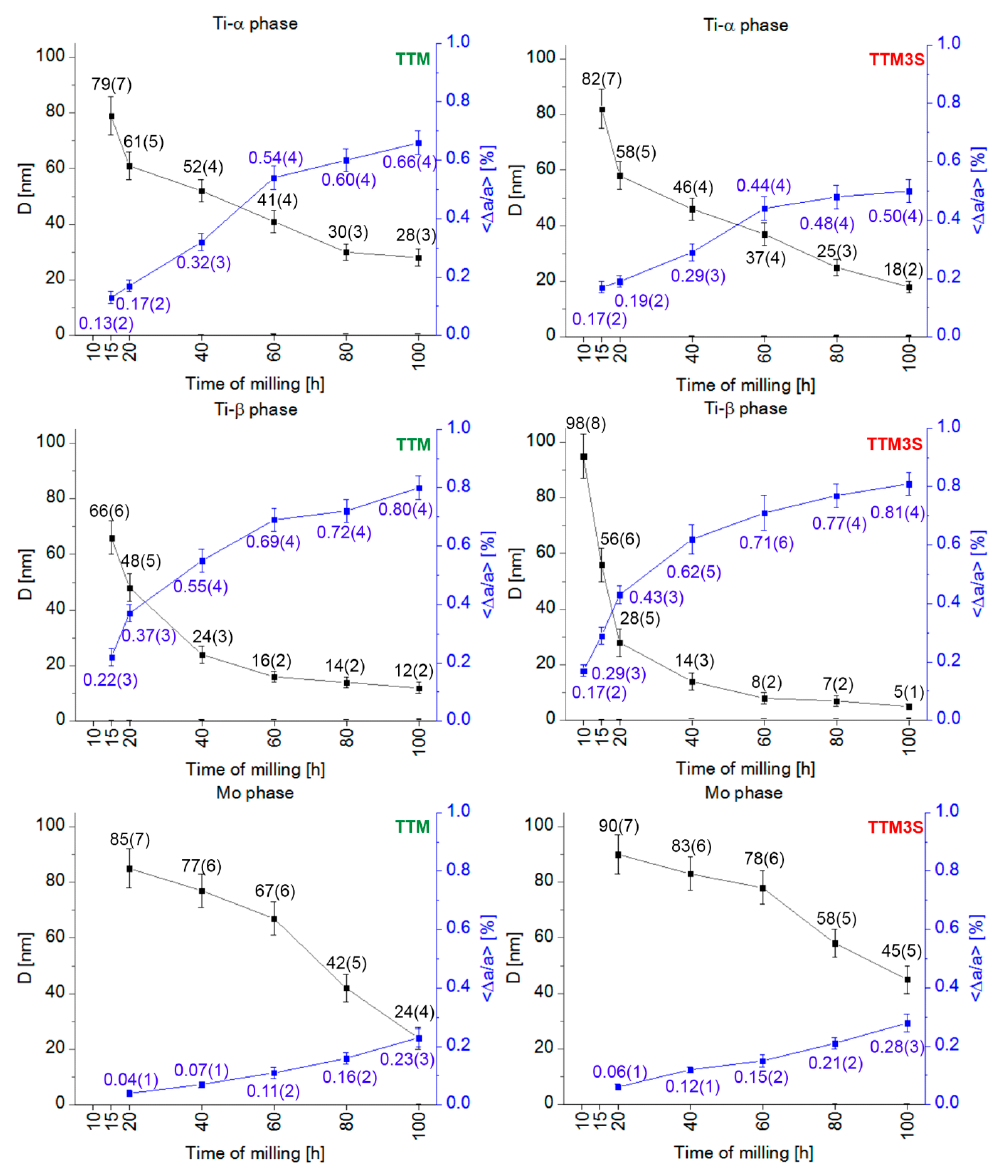
Figure 7. Changes in the average crystallite size (D) and lattice distortion ( < ∆ a / a > ) of the weight fractions of the α , β and Mo phases of the TTM and TTM3S powders after 10, 15, 20, 40, 60, 80 and 100 h of milling.